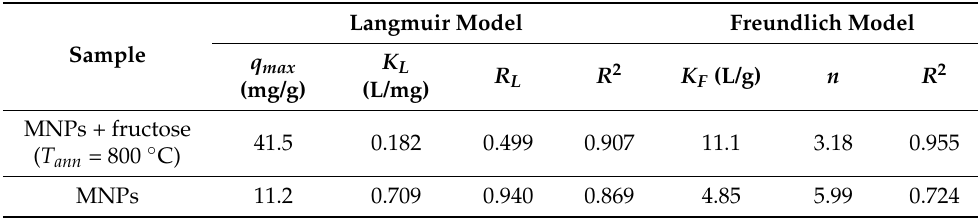
Table 4. Adsorption isotherms parameters for adsorption of Cr (VI) in the presence of the annealed sample ( T ann = 800 ◦ C) and initial MNPs.